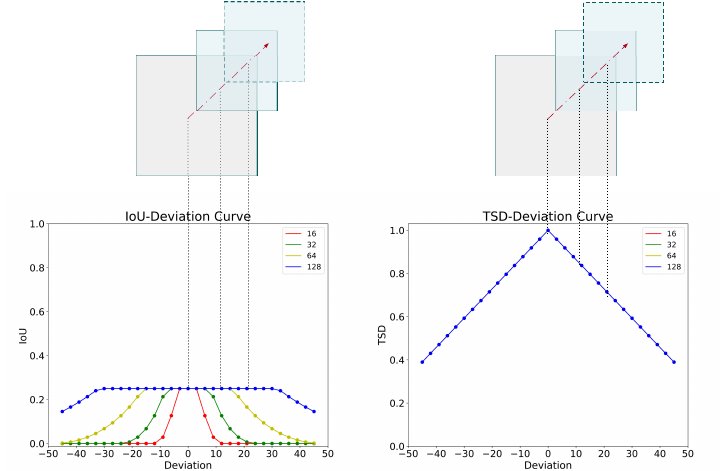
Figure 3. A comparison between IoU-deviation curve and TSD-deviation curve in four different scenarios. The abscissa value denotes the number of pixels of deviation between the center points of A and B, and the ordinate value denotes the corresponding metric value. On the left is the IoU-deviation curve, and on the right is the TSD-deviation